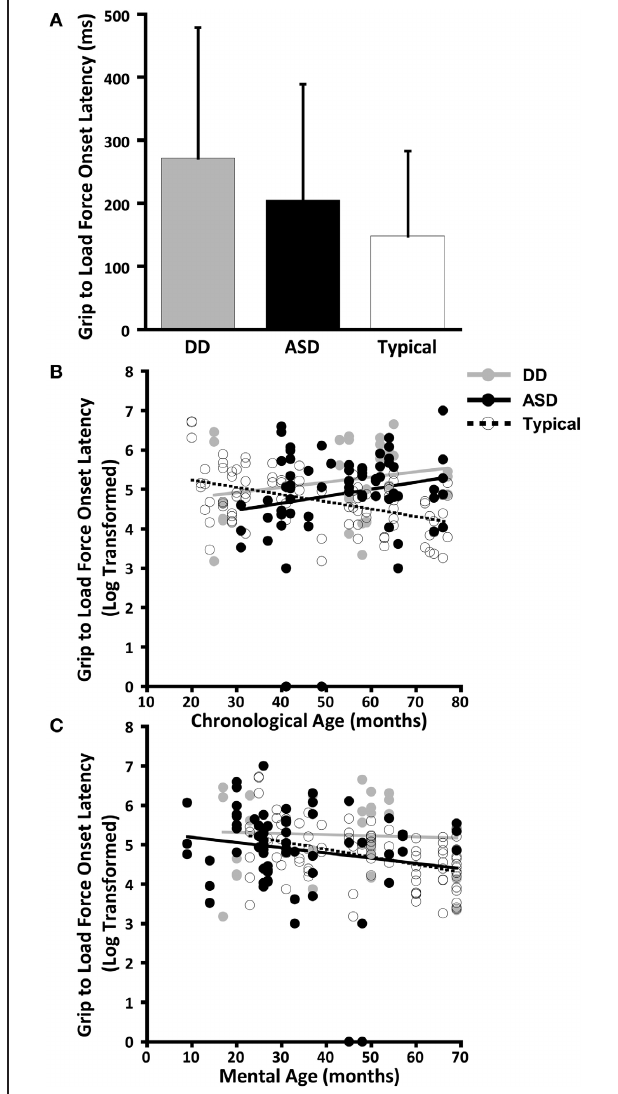
FIGURE 2 | Grip to load force onset latency. (A) Means and standard deviations. (B) The effect of chronological age. (C) The effect of mental age.